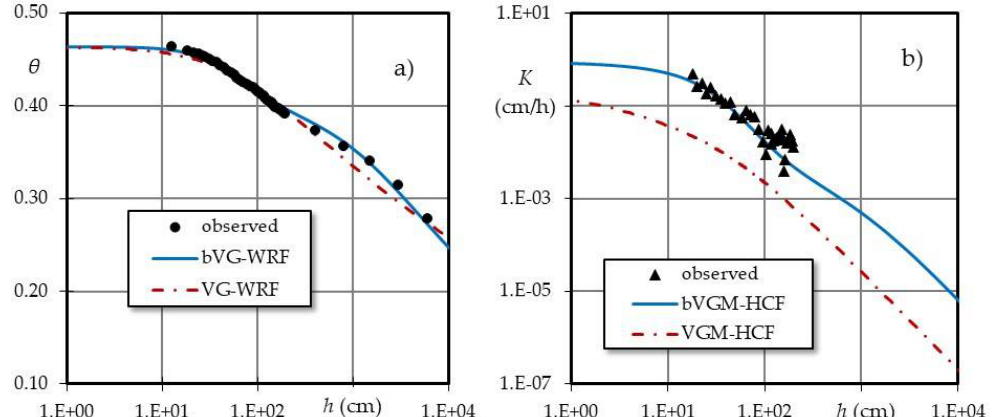
Figure 2. Fitted soil water retention ( a ) and predicted unsaturated hydraulic conductivity ( b ) curves of a soil core collected at the Monteforte Cilento (MFC2) experimental site of the Alento critical zone observatory (CZO). The observed data points were determined by the evaporation method. The dot-dashed red curves refer to the unimodal van Genuchten–Mualem (vGM) relations, whereas the solid blue curves refer to the bimodal vGM relations.